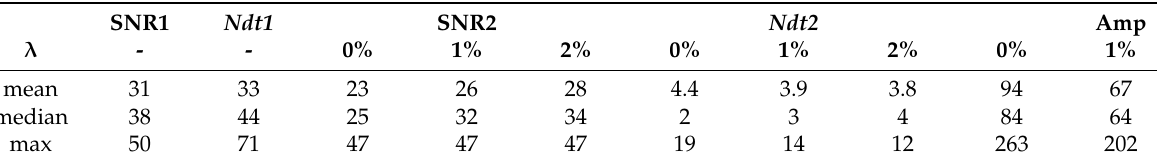
Table 3. Simulation 2: mean, median and maximum values of the sensor-level signal-to-noise ratio